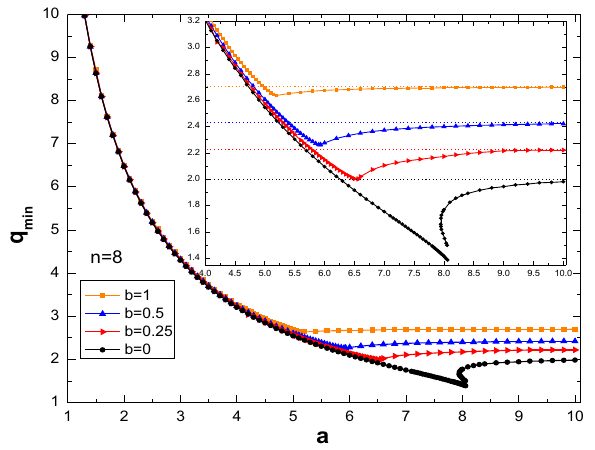
Fig. 5 The full phase diagram of q min against a with the Born–Infeld parameters b = 0 . 25 , 0 . 5 , 1, represented by the red, blue and orange lines,respectively.TheblacklinecorrespondstothecaseoftheMaxwell